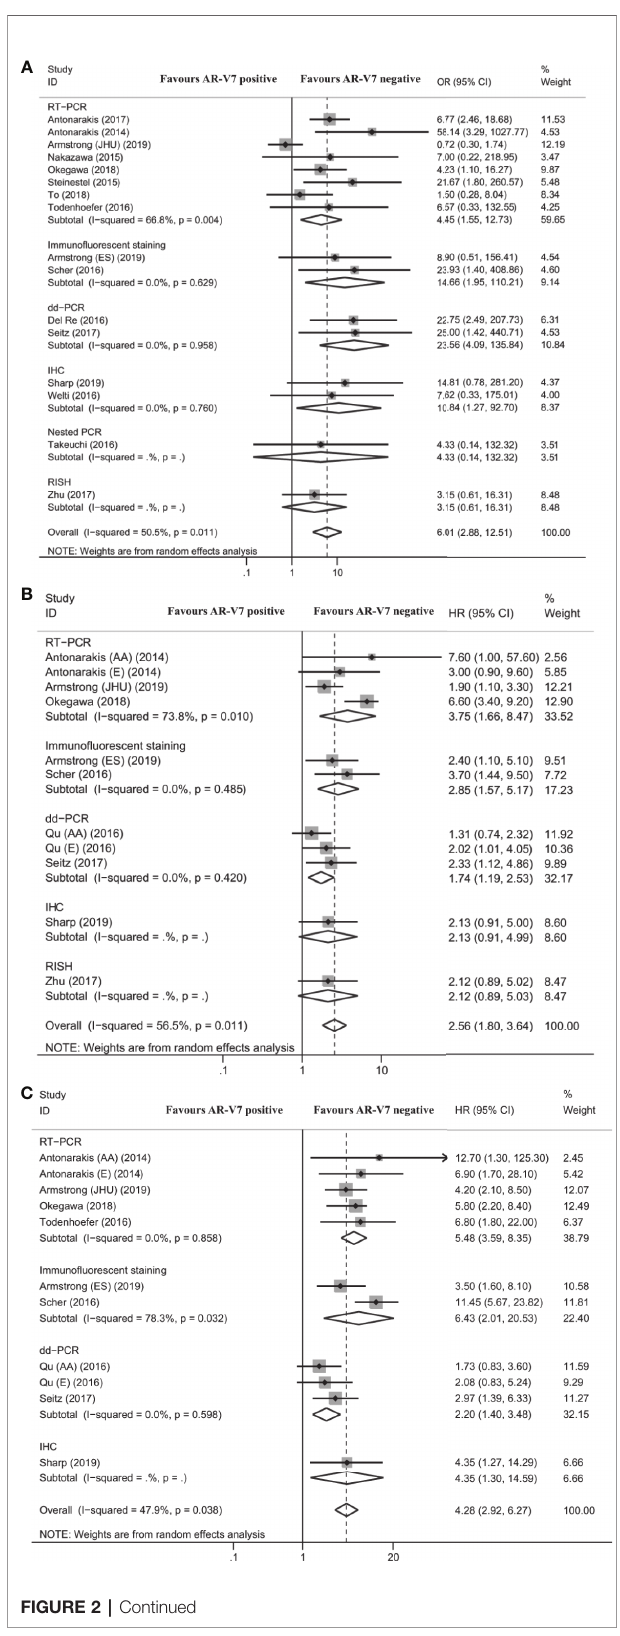
FIGURE 2 | Forest plot of mCRPC patients treated with androgen receptor signaling inhibitors by different AR-V7 status. (A) prostate-speci fi c antigen (PSA) response rate; (B) progression free survival (PFS); and (C) overall survival (OS). JHU and ES were the 2 cohorts described respectively by Armstrong et al. AR-V7, androgen receptor splice variant 7; OR, odds ratio; CI, con fi dence interval; RT-PCR, reverse transcriptase-polymerase chain reaction; dd-PCR, digital-droplet polymerase chain reaction; IHC, immunohistochemistry; PCR, polymerase chain reaction; RISH, RNA in situ hybridization; HR, hazard ratio; AA, abiraterone acetate;